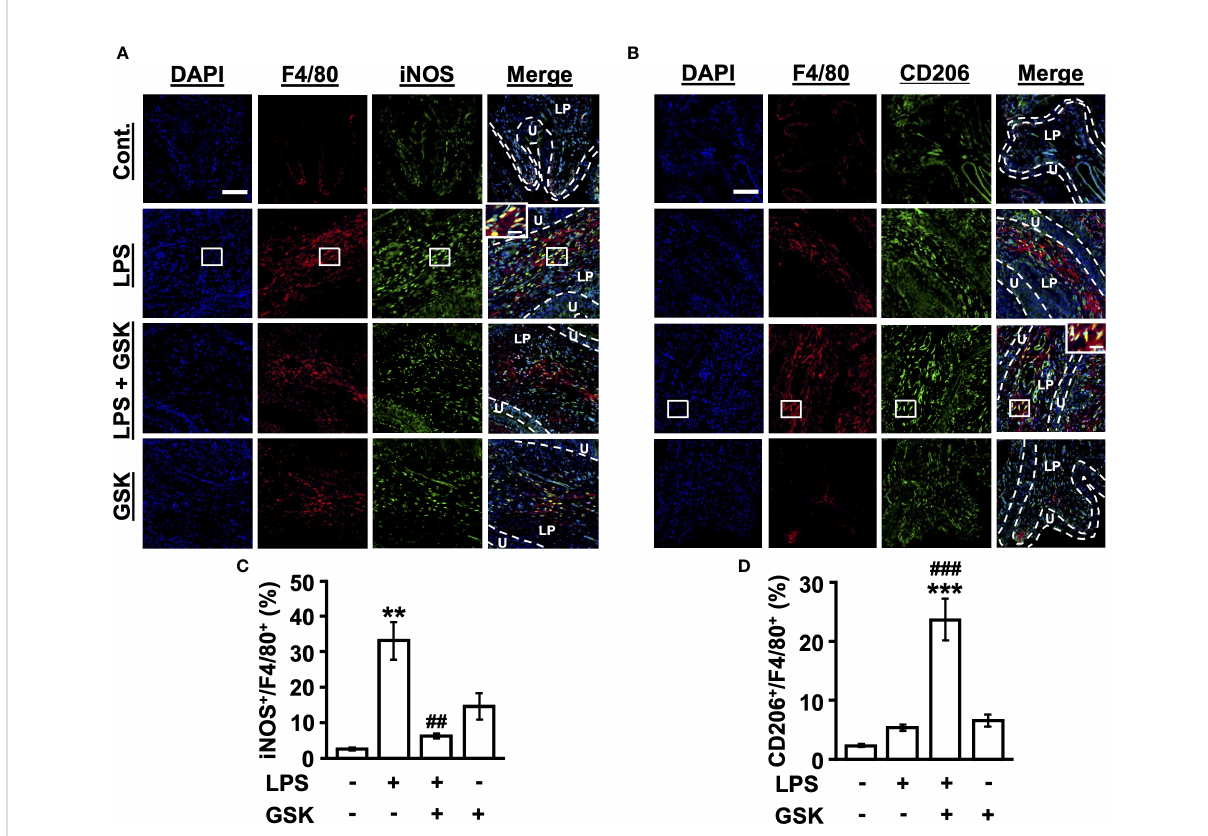
FIGURE 5 GSK regulates M1/M2 macrophage polarization in rat bladder. (A) Immunostaining of iNOS + F4/80 + macrophages in bladder tissues for each group. (B) Immunostaining of CD206 + F4/80 + macrophages in bladder tissues for each group. Magni fi cation 20× (object lens), scale bars, 100 m m. The boxed region from the merge is enlarged in the inset (scale bars, 20 m m). (C) Quantitative analysis of iNOS + (M1 marker) cells as a percentage of total F4/80 + cells in rat bladder tissues. (D) Quantitative analysis of CD206 + (M2 marker) cells as a percentage of total F4/80 + cells in rat bladder tissues. Data represent the mean ± SEM; n = 4 for each group. ** P < 0.01, *** P < 0.001 vs control. ## P < 0.01, ### P < 0.001 vs LPS. U, urothelium; LP, lamina